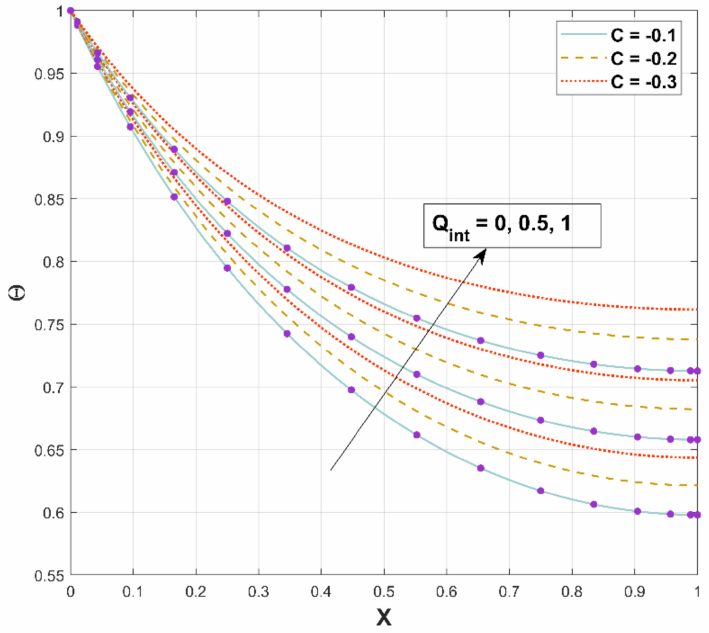
Figure 10. Upshot of Q int on Θ